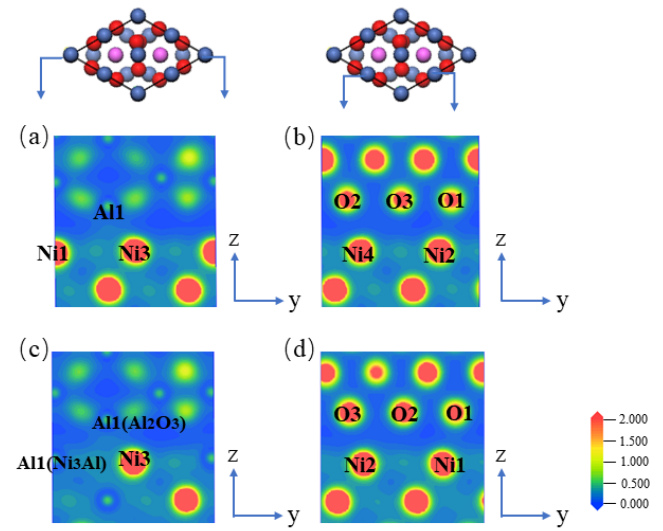
Figure 6. ( a , b ) Charge densities of different sections of the Ni(111)/Al 2 O 3 (001) interface; ( c , d ) charge densities of different sections of the Ni 3 Al(111)/Al 2 O 3 (001) interface. The pink, red, and blue ball in figure shows Al, O, Ni atom separately.